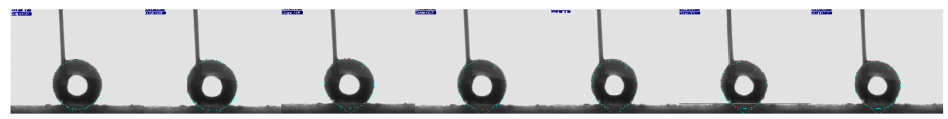
Figure 6. The contact angle increased to the advancing contact angle measured on the travertine stone coated with the octyl-modified silica nanostructured film.